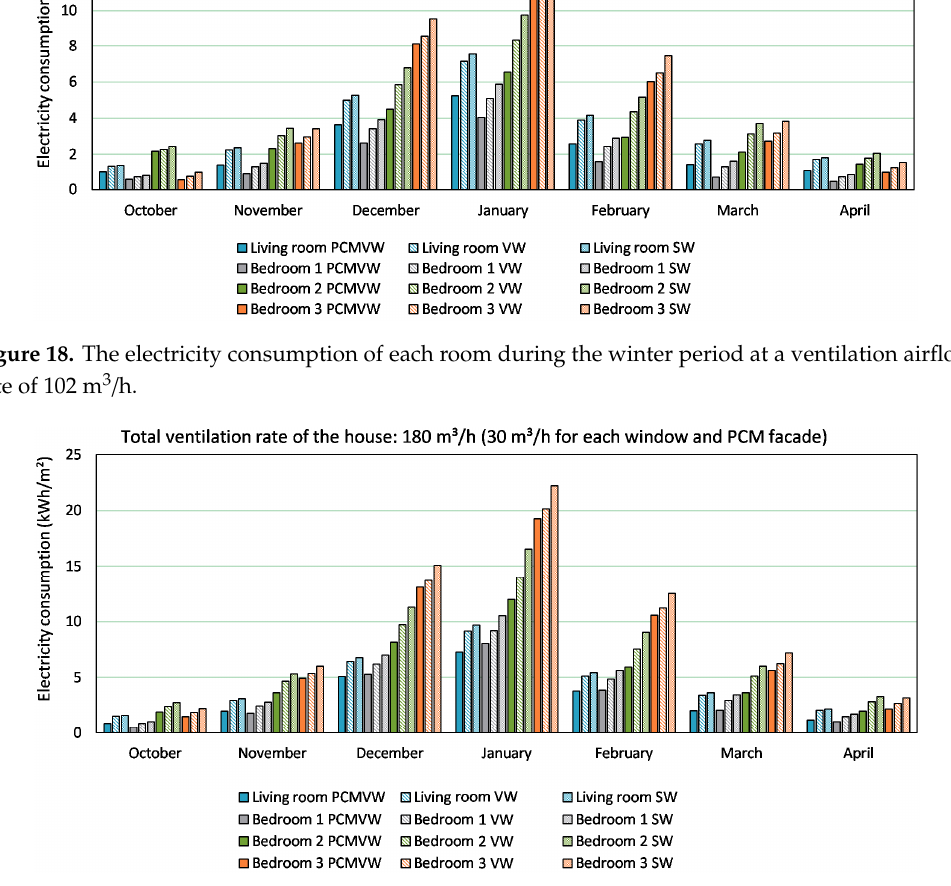
Figure 19. The electricity consumption of each room during the winter period at a ventilation airflow rate of 180 m 3 /h.